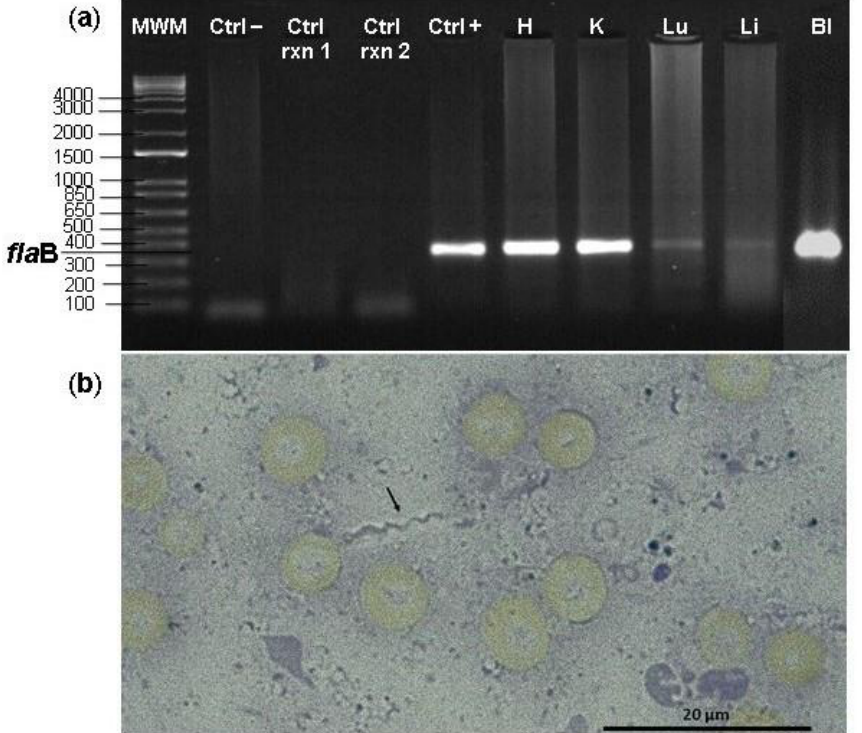
Figure 2. ( a ) Agarose gel showing the products of nested PCR targeting the flagellin B ( fla B) gene from Artibeus lituratus tissues: (MWM): Molecular weight marker (1 Kb plus InvitrogenTM), (Ctrl − ) negative control, (Ctrl rxn 1) first PCR reaction control, (Ctrl rxn 2) nested PCR reaction control, (Ctrl +) positive control Borrelia anserina , (H) heart, (K) kidney, (Lu) lung, (Li) liver, (Bl) blood. ( b ) Spirochete found in liver impression smear from a bat from Sturnira erythromos species. Twenty-four (24) partial sequences of the flaB gene (~315 pb) were obtained and were deposited in GenBank with accession codes [OP491407-OP491408; OP480441-OP480462]. Seven of these sequences showed identity between 99.19% – 99.64% with B. venezuelensis [MG651650] and Borrelia turicatae [MH632129] from the RFG. Two sequences showed an identity of 99.64% and 100% with B. burgdorferi s.s. [CP002228; AY374137] from the LDG, and 15 sequences showed an identity between 94.52% and 98.56% with one of the Borrelia genospecies [MT154618] found in Macaregua Cave in Colombia. Furthermore, four allelic variants were found in the Borrelia typing database, one for RFG and three for LDG (Table 1). The phylogenetic reconstruction obtained by ML using flaB sequences showed that two of the sequences of this study form a monophyletic clade with B. burgdorferi s.s. with a statistical support greater than 92% and a group with the sequences of the same species that were reported in the USA and Canada, with divergences between 0 – 1.1% (Figure 3; Table S2). Another monophyletic group was formed by 15 sequences of Borrelia sp. geno- species isolated from bats in Colombia (statistical support of 98.8%), which branches as a sister group of the LDG borreliae and are related to the sequences recorded in Macaregua Cave, Colombia (Figure 3; Table S2). Finally, the remaining seven sequences had genetic distances between them of 0 – 0.4%, are associated with the RFG, and are more closely re- lated to B. venezuelensis (Brazil) with a statistical support of 83.5% in the ML tree and with genetic distances between 0 – 1.1% (Figure 3; Table S2).